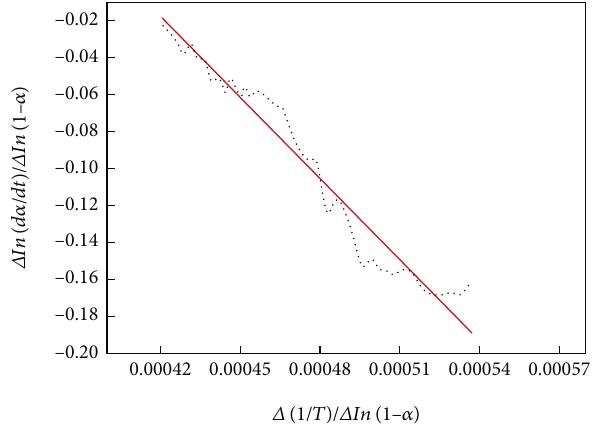
Figure 9: Thermal degradation kinetic curves of SD +CA in 92.8 – 249.6 °